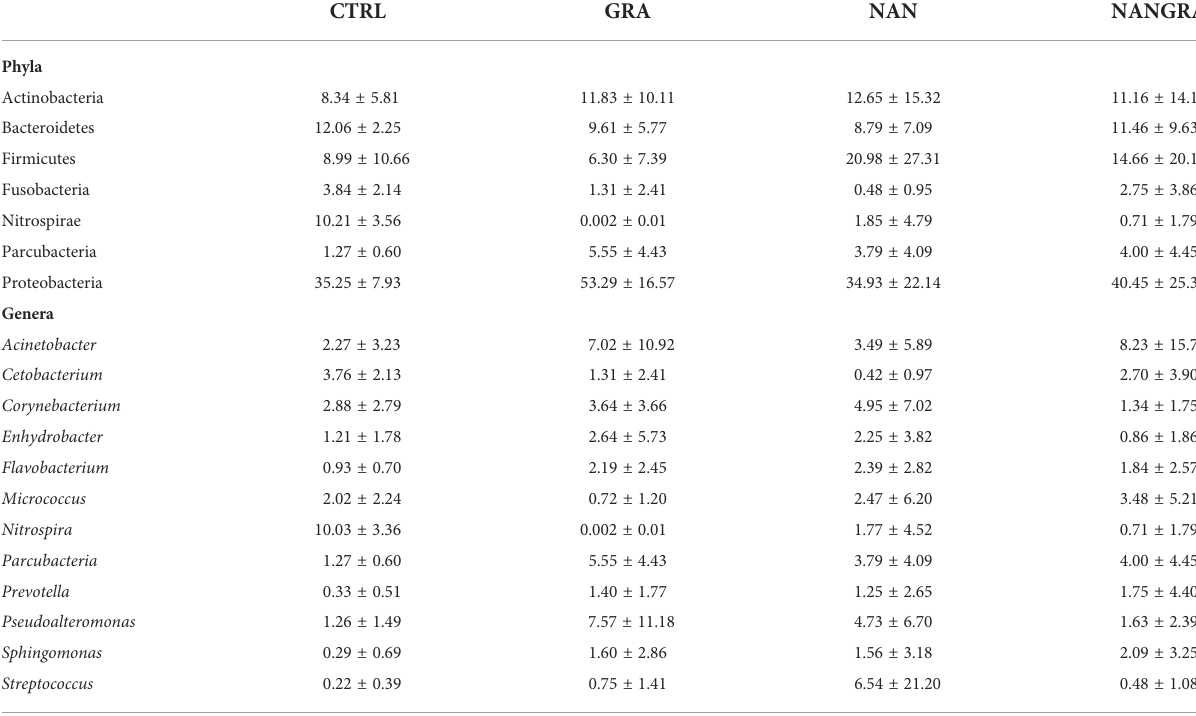
TABLE 1 Average relative abundance (%) of the dominant bacterial phyla and genera in the posterior intestine of European seabass fed the experimental diets.